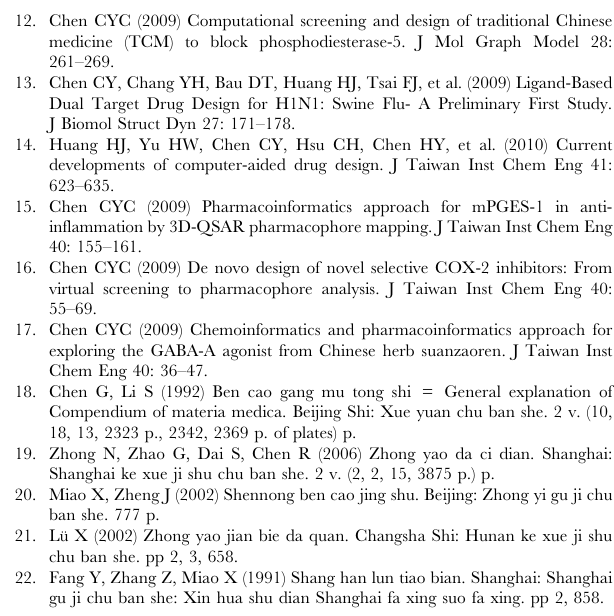
Table S1 Summary of medicines present in each TCM class. The English translation of each class is taken from WHO publication.